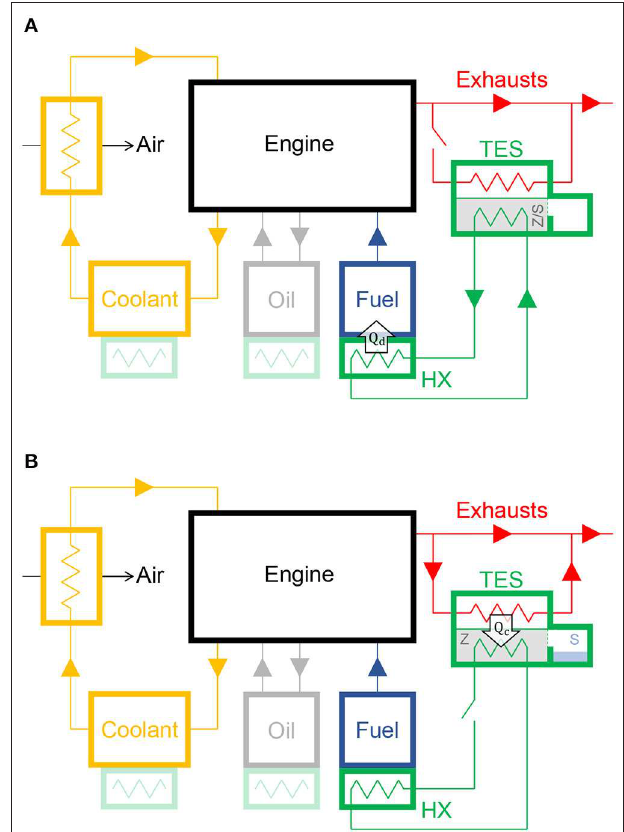
FIGURE 6 | Schematics of a Thermal Energy Storage (TES) system based on the proposed zeolite sorbent and liquid sorbate to pre-heat the fuel and/or lubricant (oil) and/or coolant of a Diesel engine of an electric stand-by generator set (F9.5-1 by FG Wilson) during the cold-start. (A) Heat discharge phase: the liquid sorbate (S) is released into the chamber containing the zeolite (Z), thus hydrating it (Z/S). The thermal energy released by the hydration process is collected by a heat transfer fluid and then exchanged with the fuel and/or oil and/or coolant tank via an heat exchanger (HX). The energy provided to the engine fluids is equal to Q d . (B) Heat charge phase: the thermal energy recovered from the exhaust gases is employed to dehydrate the sorbate from the zeolite. The energy provided to the TES system is equal to Q c